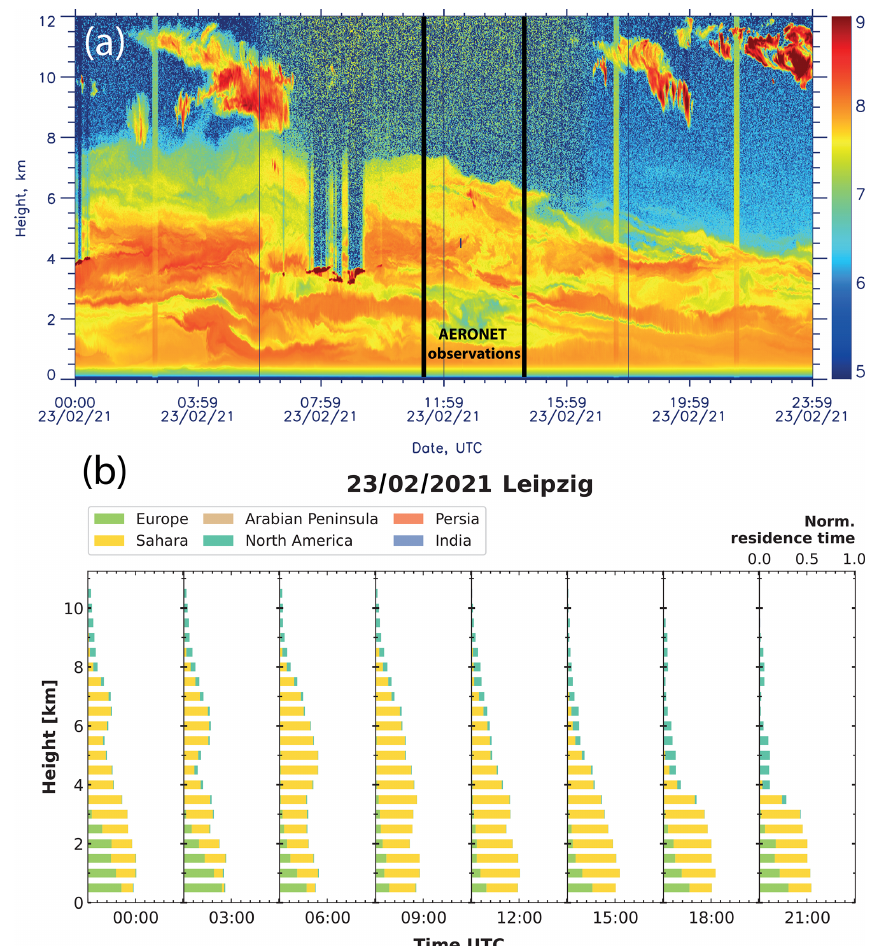
Figure 2. Development of the dust layer over Leipzig on 23 February 2021. (a) Cross-polarized, range-corrected signal at 532nm measured with Polly XT (color scale in arbitrary units). The period of the five AERONET observations is marked by thick black vertical bars (please note that the date format in this panel is day/month/year). (b) Source attribution in 3h intervals by using the method of Radenz et al. (2021). The normalized residence time of the air masses close to the ground (below 2km height) within 10d prior to the arrival over Leipzig at the indicated timestamps on 23 February 2021 is shown. The trajectory calculations are based on FLEXPART (FLEXible PARTicle dispersion model). The colors indicate different regions defined in Radenz et al. (2021). Here, the Sahara, continental Europe and North America are